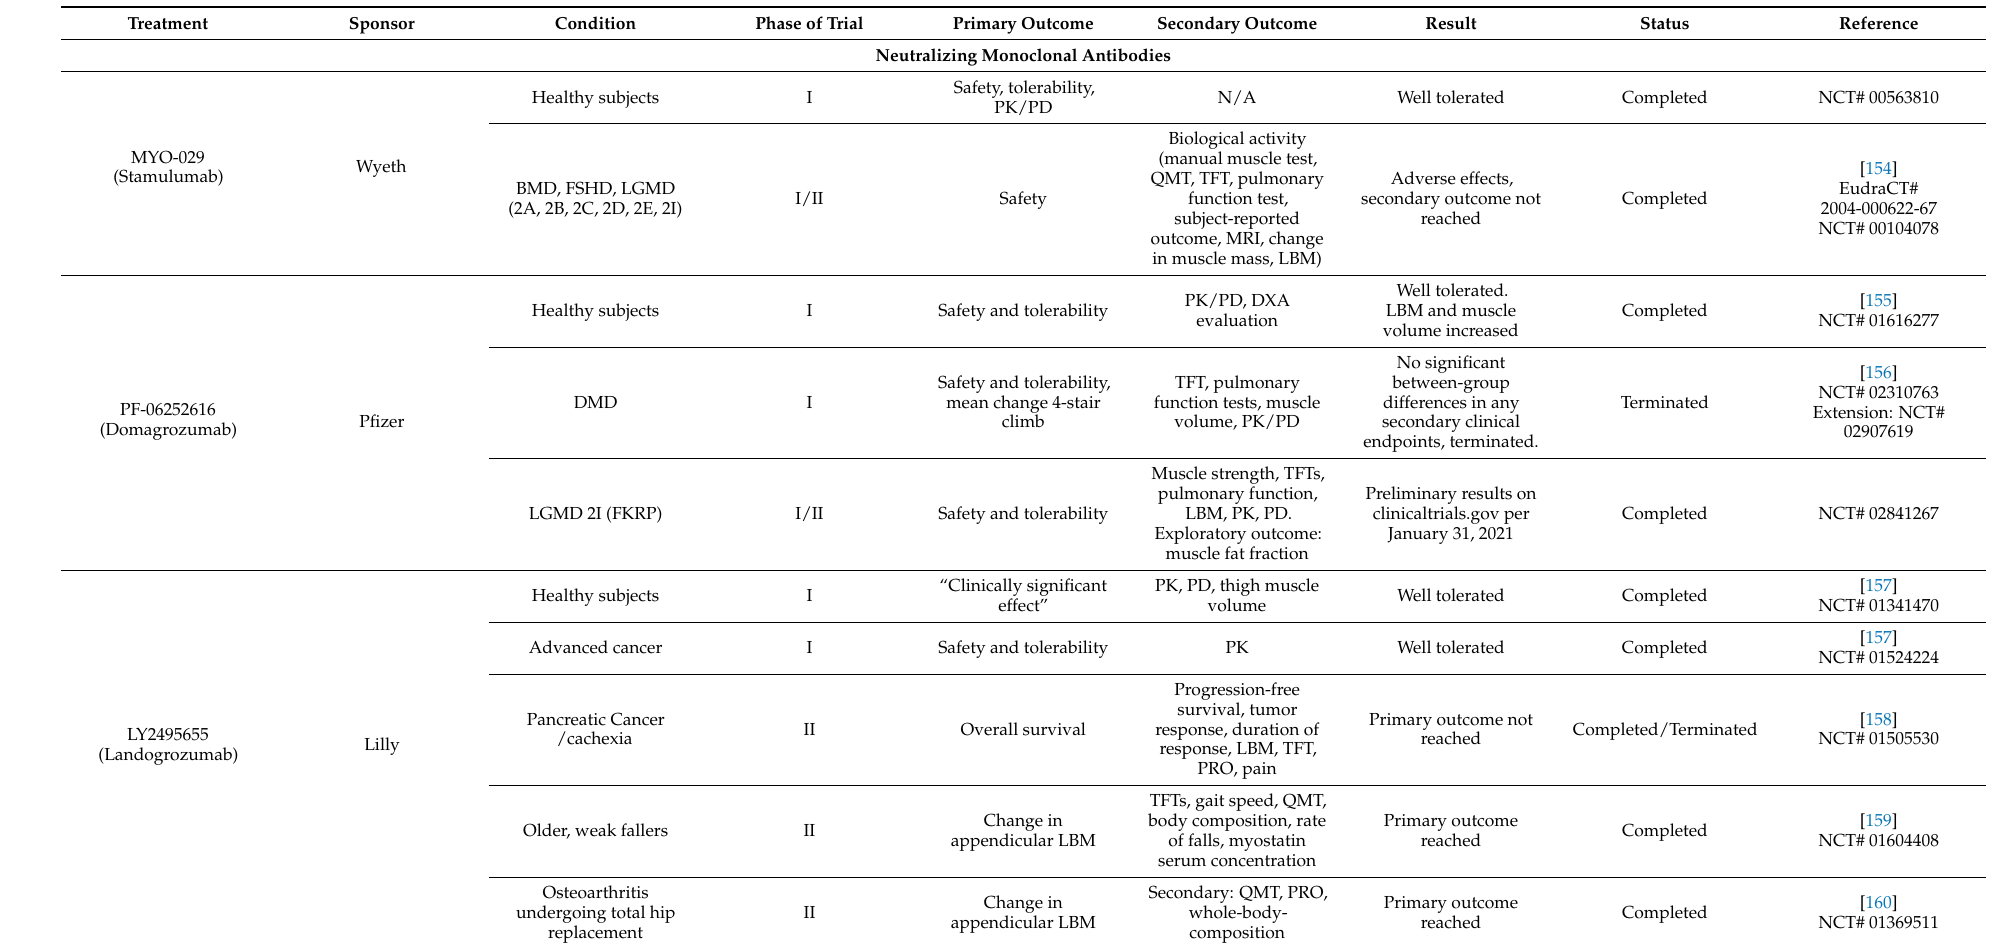
Table 2. Overview of published and unpublished clinical trials with myostatin inhibitors as per PubMed-U.S. National Library of Medicine and www.clinicaltrialsregister.eu and www.clinicaltrials.gov (access date 23 February